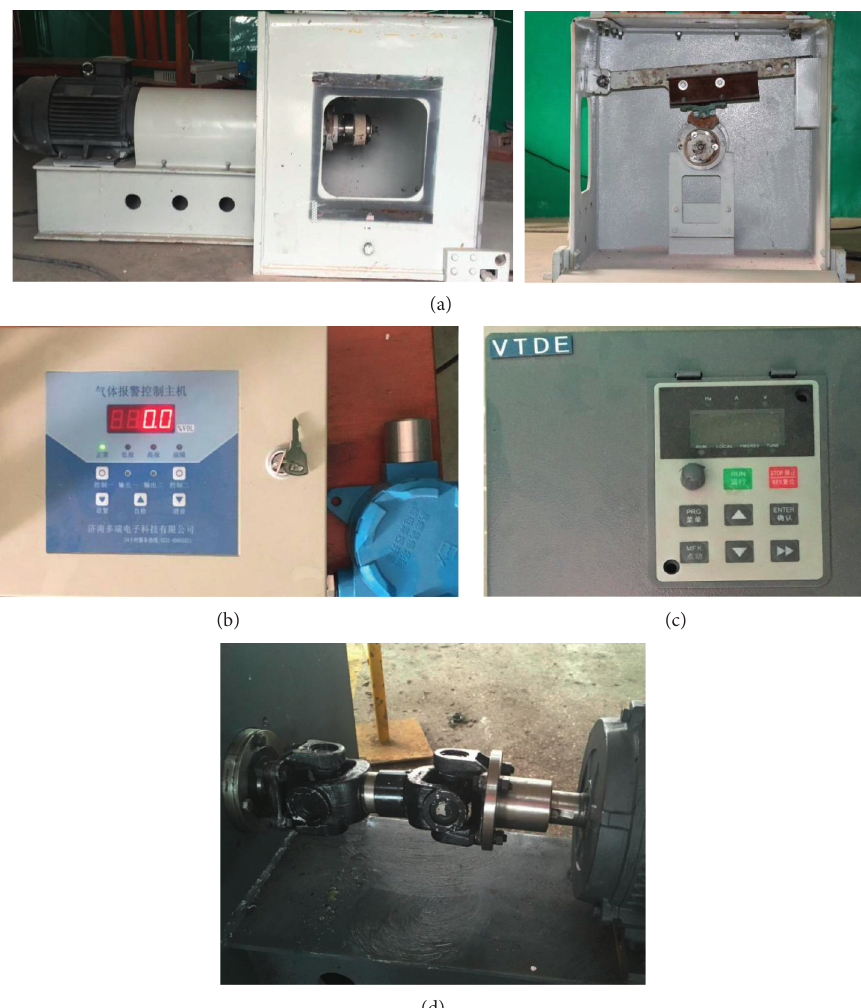
Figure 4: Test equipment. (a) Friction test box. (b) Gas monitoring device. (c) Speed control device. (d) Connection box.